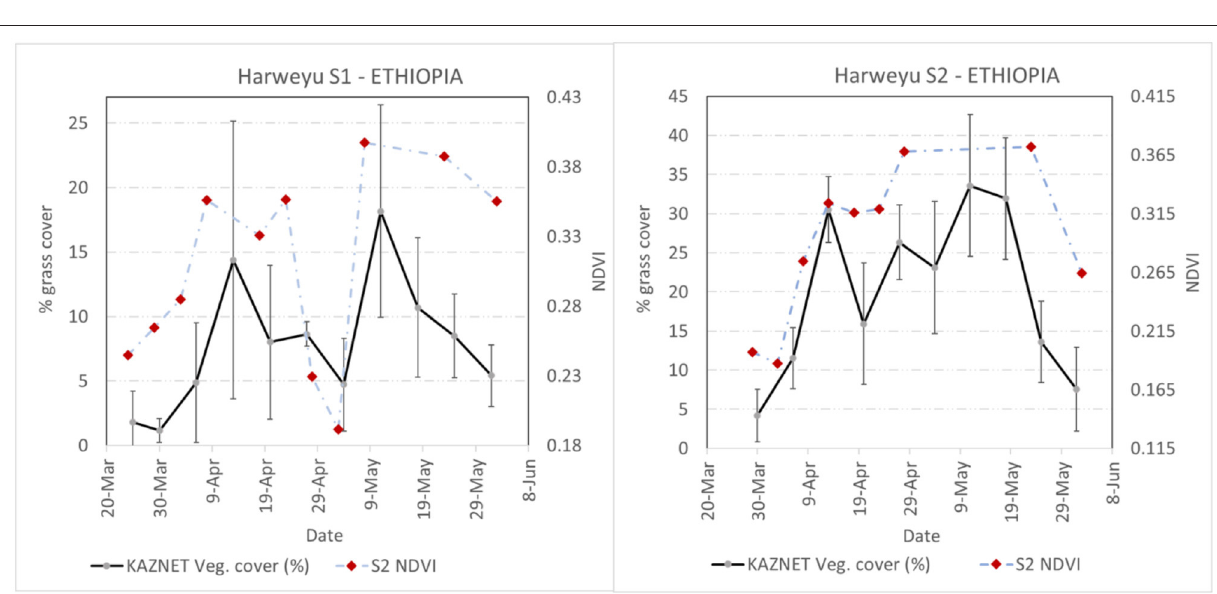
Frontiers in Sustainable Food Systems |